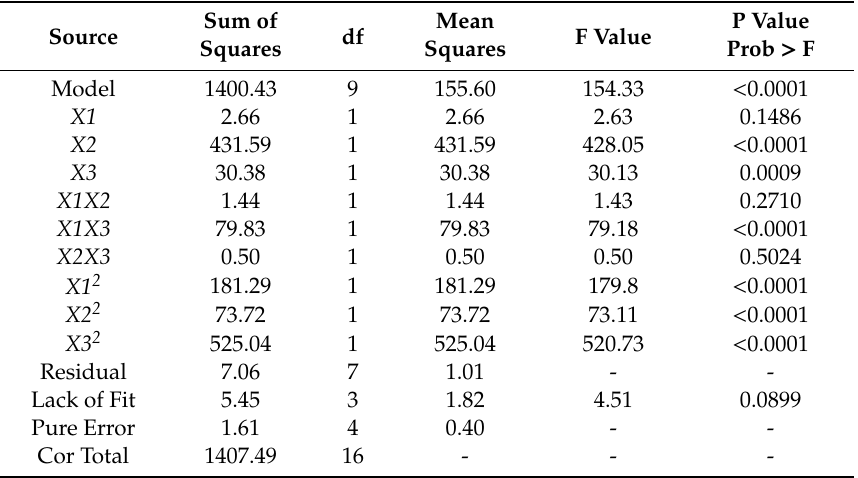
Table 4. Statistical results of regression analysis.